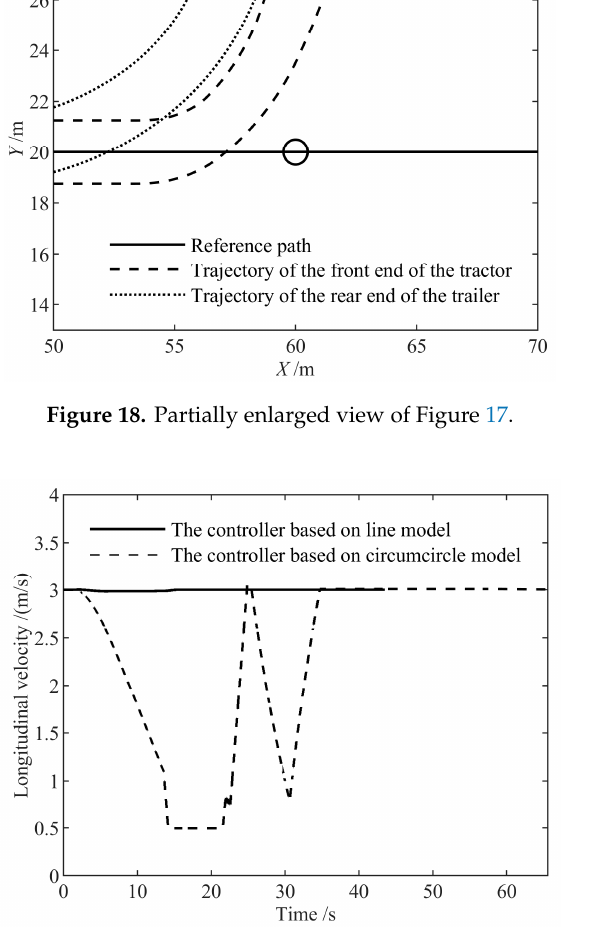
Figure 19. Longitudinal velocity in the second group of